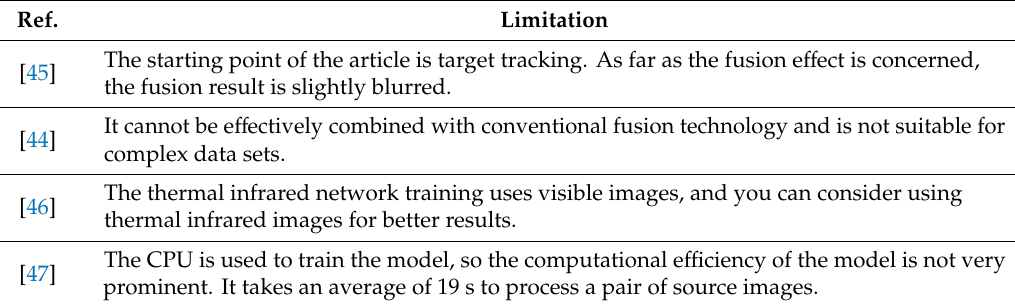
Figure 3. Siamese network-based infrared and visible image fusion scheme (credit to [44]). Table 3. The overview of Siamese network-based fusion methods.